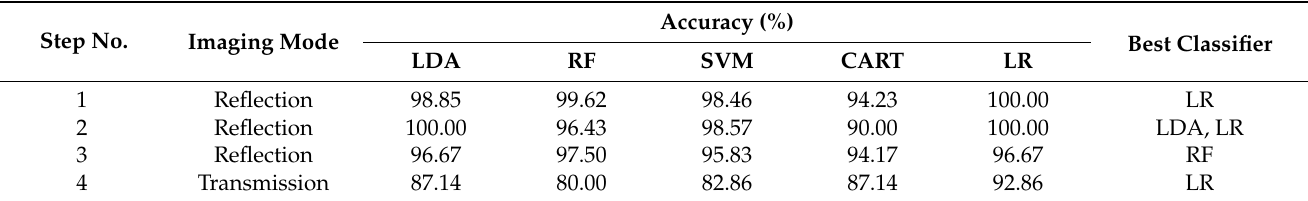
Table 1. The best set of classifiers for each step of the classification models.